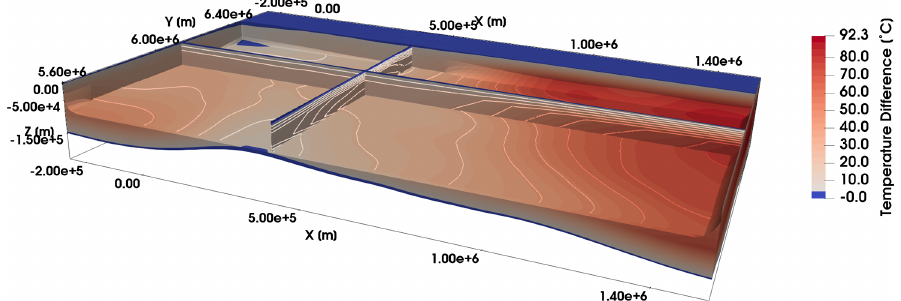
Figure 15. Difference in the temperature distribution between the state at 255.7Ma and 75.8Ma for the transient simulation considering a simulation time of